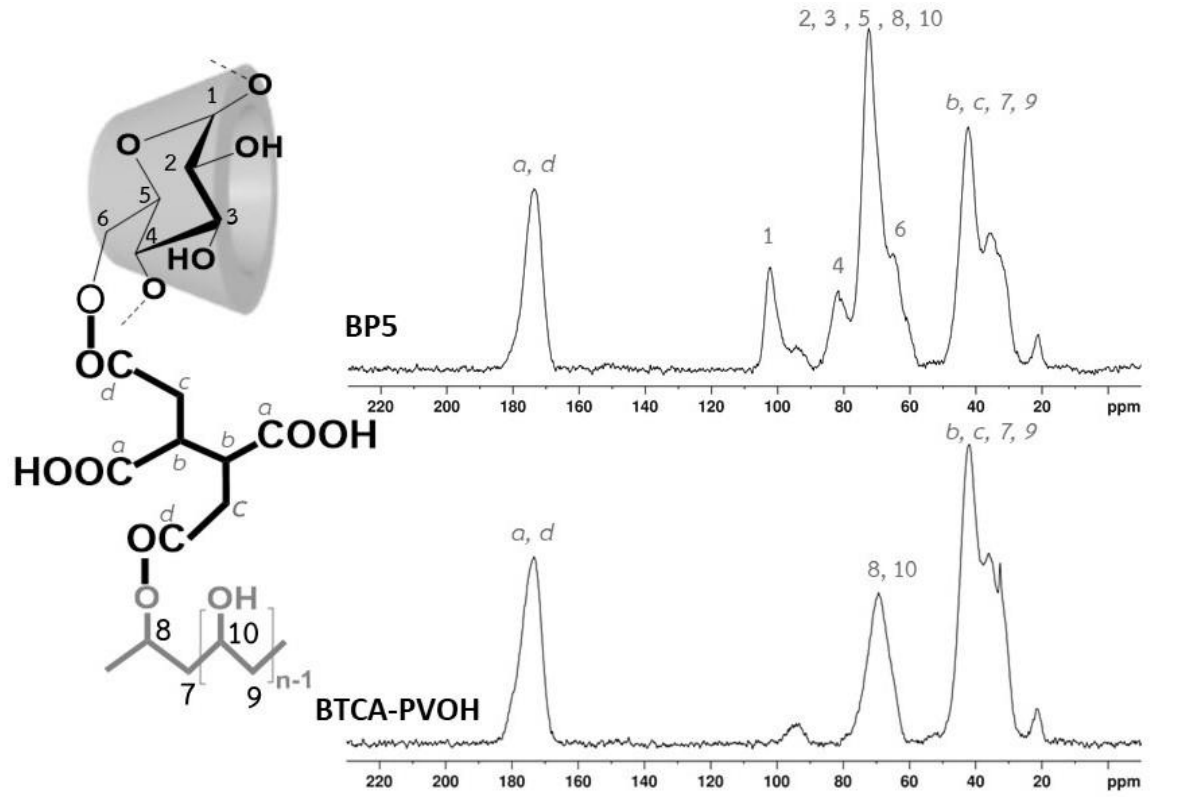
Figure 5. 13 C NMR spectra of BTCA-PVOH and BP5 nanosponges.